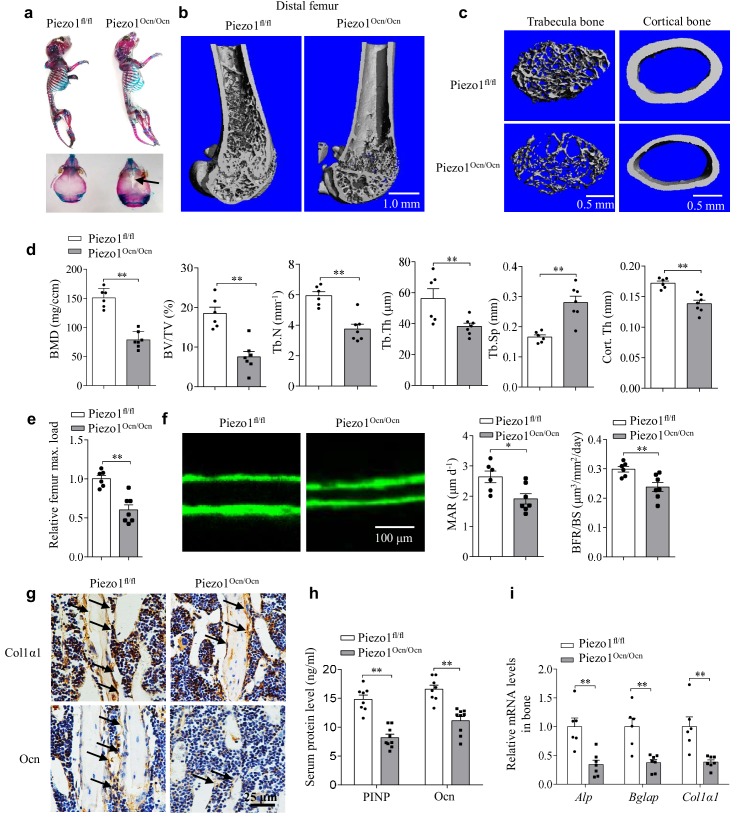
Piezo1Ocn/Ocn mice show severely impaired bone formation.(a) Alcian blue and Alizarin red staining of the skeletons of Piezo1fl/fl or Piezo1Ocn/Ocn mice at 7 days old. (b, c) Representative images showing the three-dimensional cortical bone and trabecular architecture as shown by micro-CT reconstruction at the distal femurs from Piezo1fl/fl or Piezo1Ocn/Ocn mice at 2 months old. Scale bars: (b) 1.0 mm, (c) 0.5 mm. (d) Micro-CT measurements for bone mineral density (BMD), trabecular bone volume fraction (BV/TV), trabecular number (Tb.N), trabecular thickness (Tb.Th), trabecular separation (Tb.Sp) and cortical thickness (Cort.Th) at the distal femurs from Piezo1fl/fl (n = 6) or Piezo1Ocn/Ocn (n = 7) mice. (e) Relative maximal (max.) load at failure determined by three-point bending of femurs from Piezo1fl/fl (n = 6) and Piezo1Ocn/Ocn mice (n = 7). (f) Representative images showing new bone formation assessed by double calcein labeling in Piezo1fl/fl mice (n = 6) and Piezo1Ocn/Ocn mice (n = 7). MAR, mineral apposition rate. BFR/BS, bone formation rate/bone surface. Scale bar, 100 μm. (g) Histology images for Col1α1 and Ocn staining of the proximal tibia from Piezo1fl/fl and Piezo1Ocn/Ocn mice. Scale bar, 25 μm. (h) ELISA analysis of the levels of PINP and Ocn protein levels in the serum from Piezo1fl/fl (n = 8) and Piezo1Ocn/Ocn mice (n = 9). (i) QRT-PCR analysis of Alp, Bglap and Col1α1 mRNA levels in bone tissues collected from Piezo1fl/fl (n = 6) and Piezo1Ocn/Ocn mice (n = 7). All data are the mean ± s.e.m. *, p<0.05; **, p<0.01.10.7554/eLife.47454.013Figure 3—source data 1.The data and statistical analysis of Piezo1Ocn/Ocn mice show severely impaired bone formation.